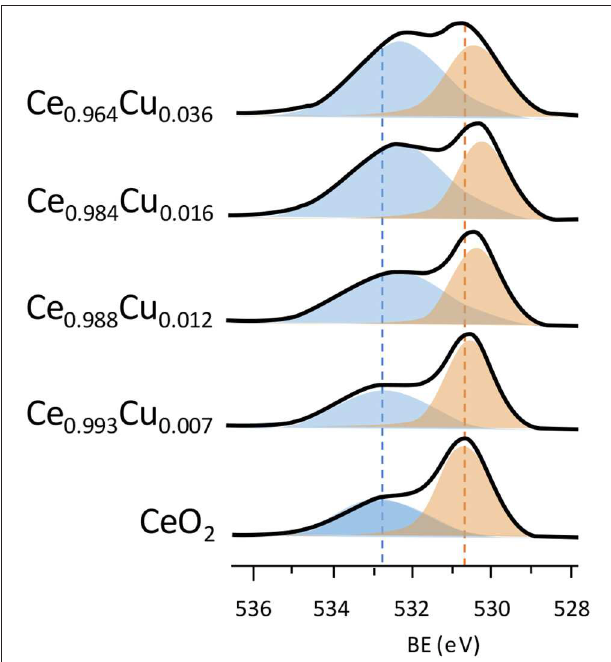
FIGURE 10 | Spectrum of XPS O1s and the effect of copper doping on ceria (adapted from Aranda et al., 2012).